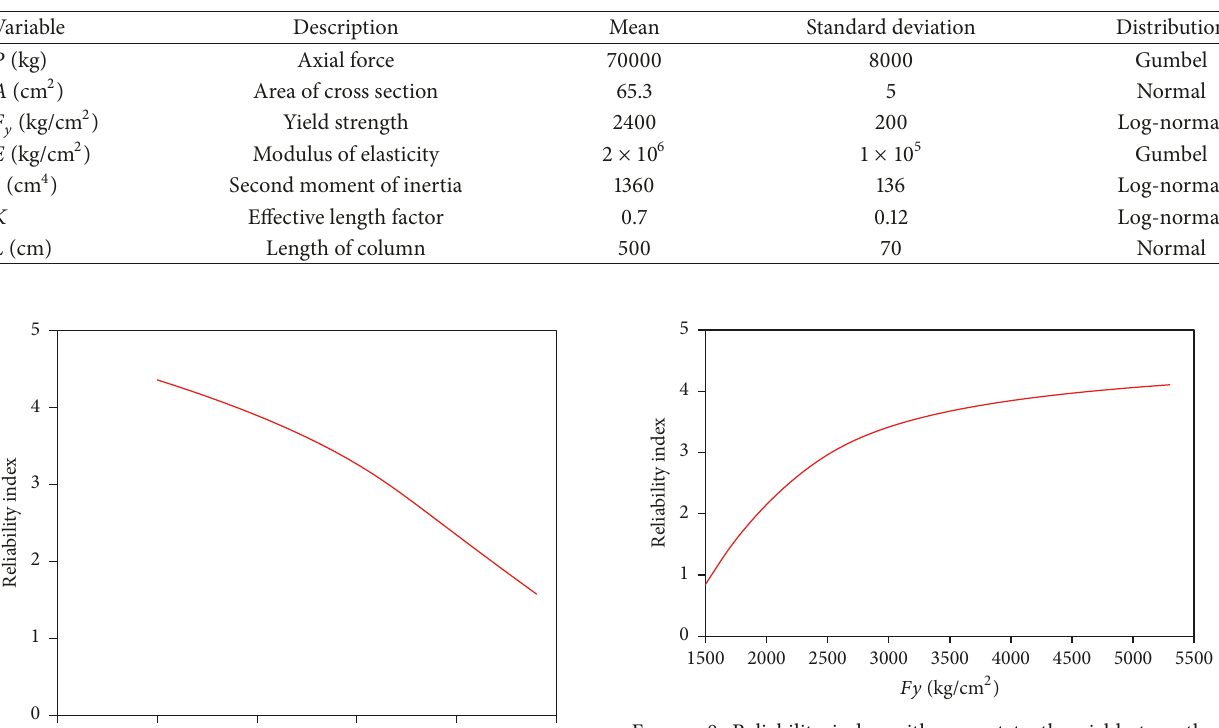
Figure 8: Reliability index with respect to the yield strength of column example.